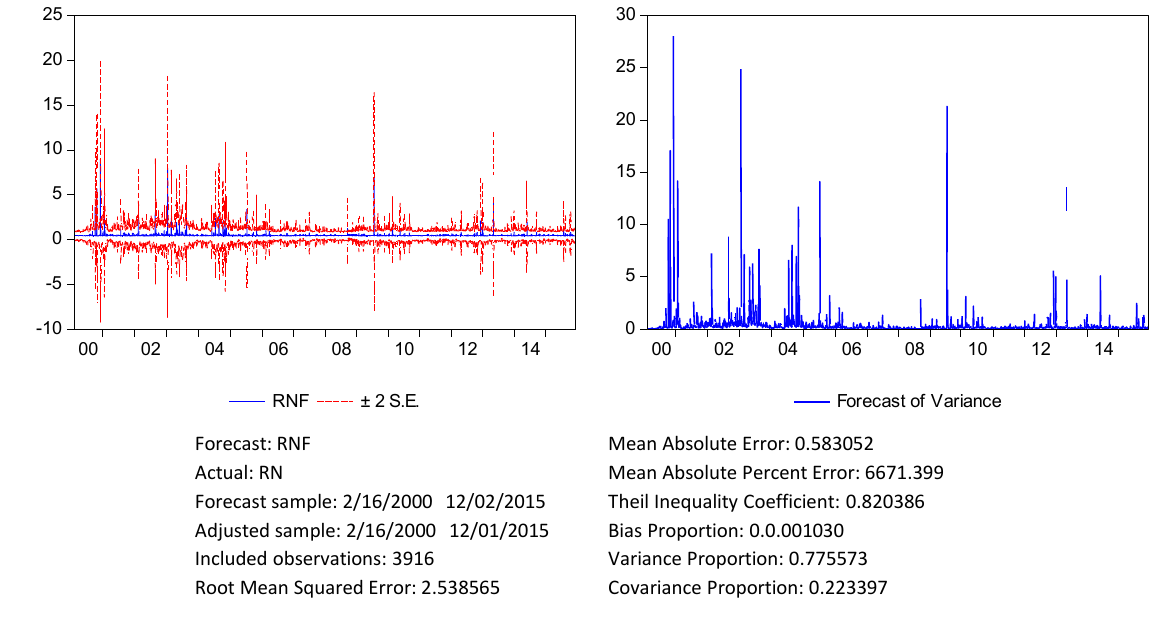
Figure 4. GARCH forecasting of the Reynolds number in